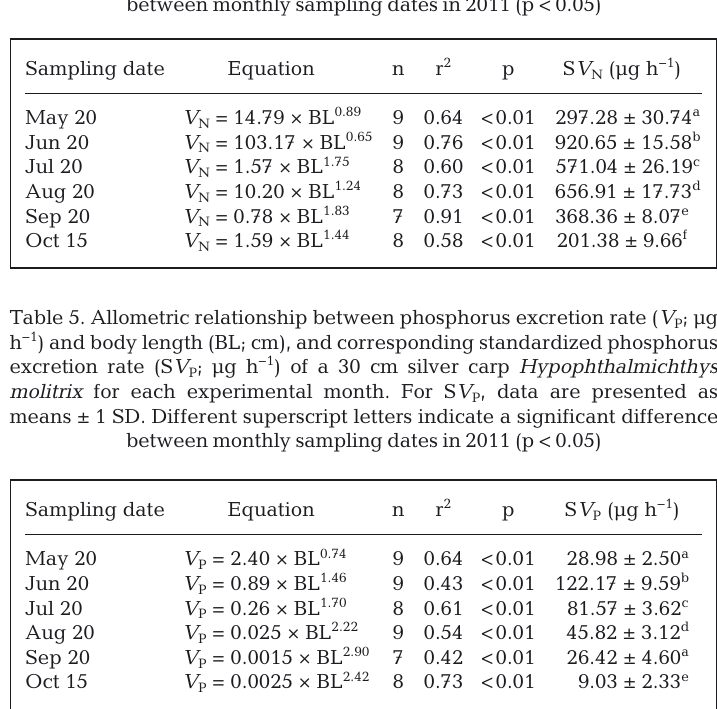
Table 4. Allometric relationship between nitrogen excretion rate ( V N ; µg h −1 ) and body length (BL; cm), and corresponding standardized nitrogen